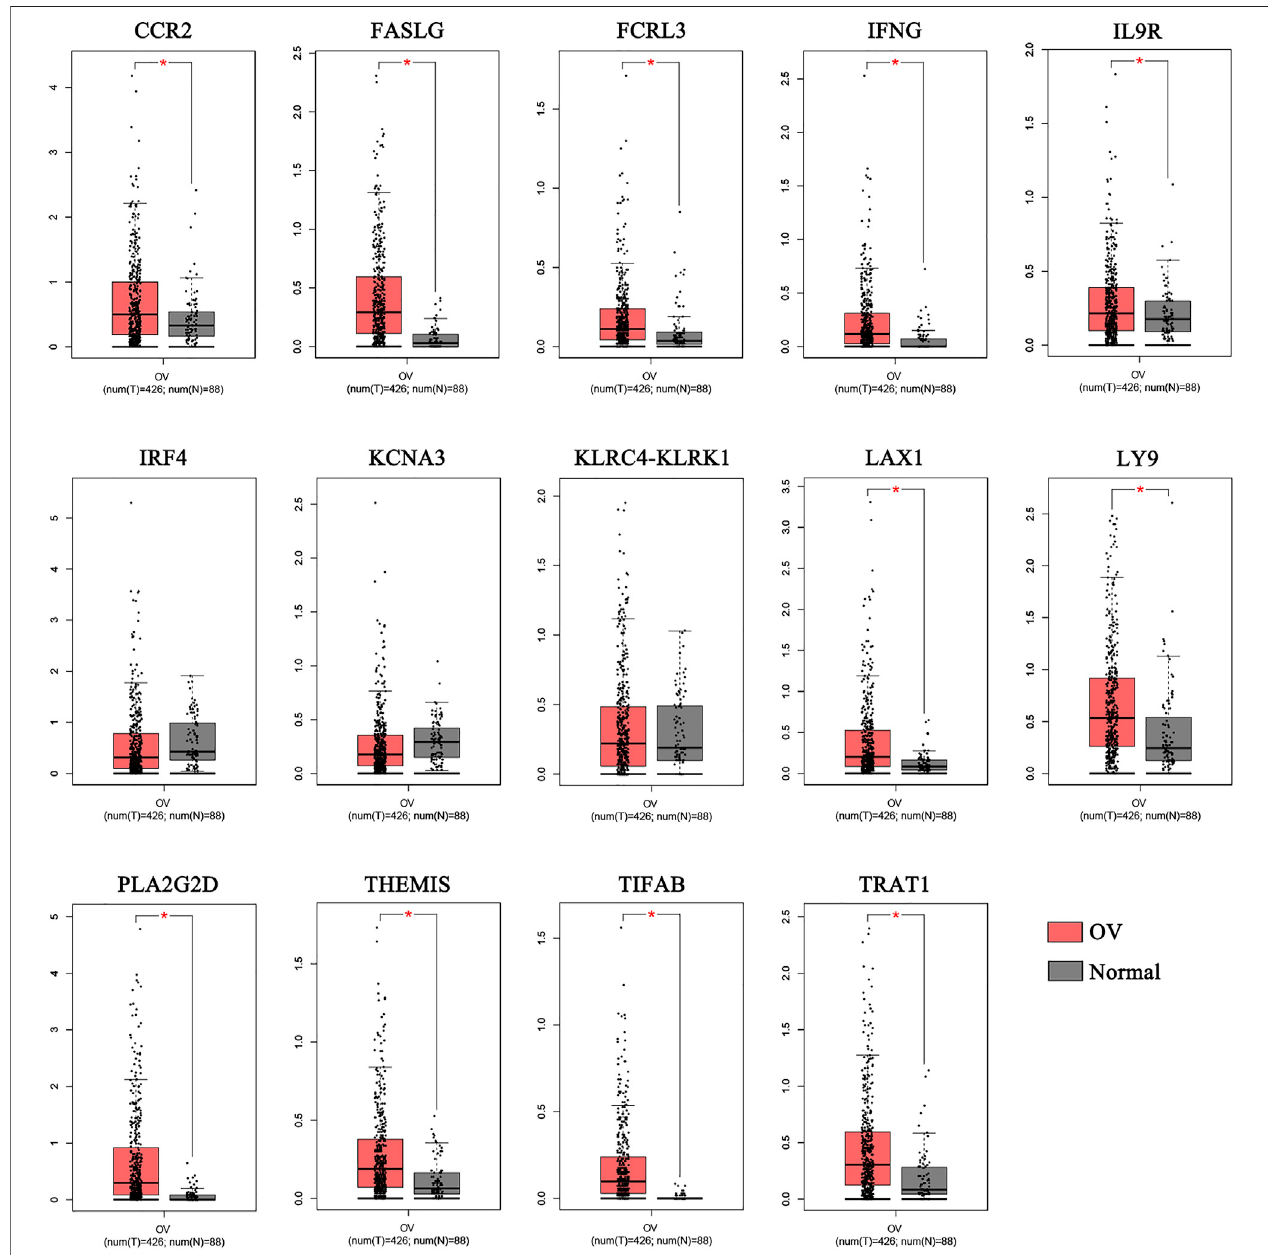
FIGURE 3 | The comparison of the expressions of the key genes between the normal and OV samples. (* p < 0.05; OV, Ovarian cancer).